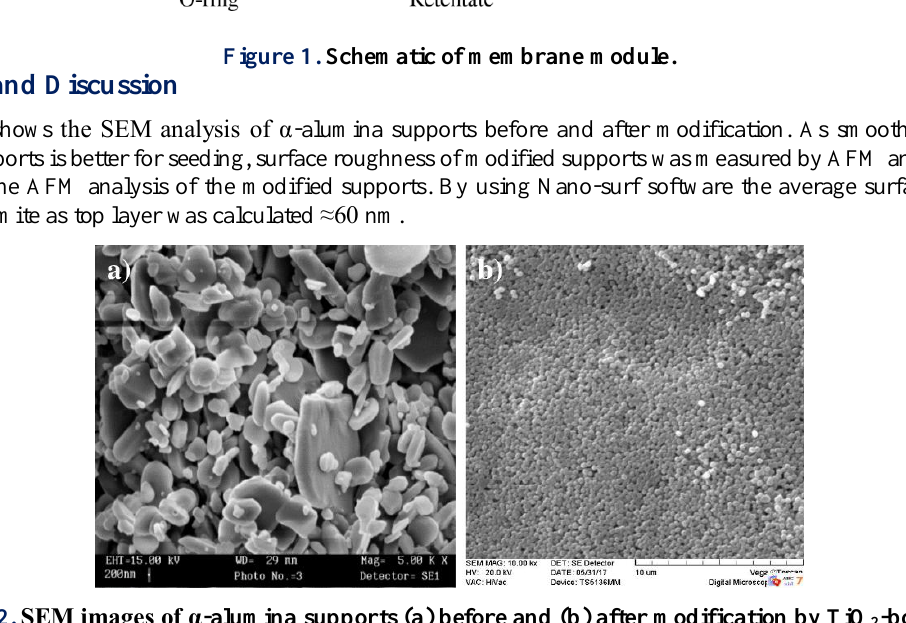
Figure 2. SEM images of α-alumina supports (a) before and (b) after modification by TiO 2 -bohemit.